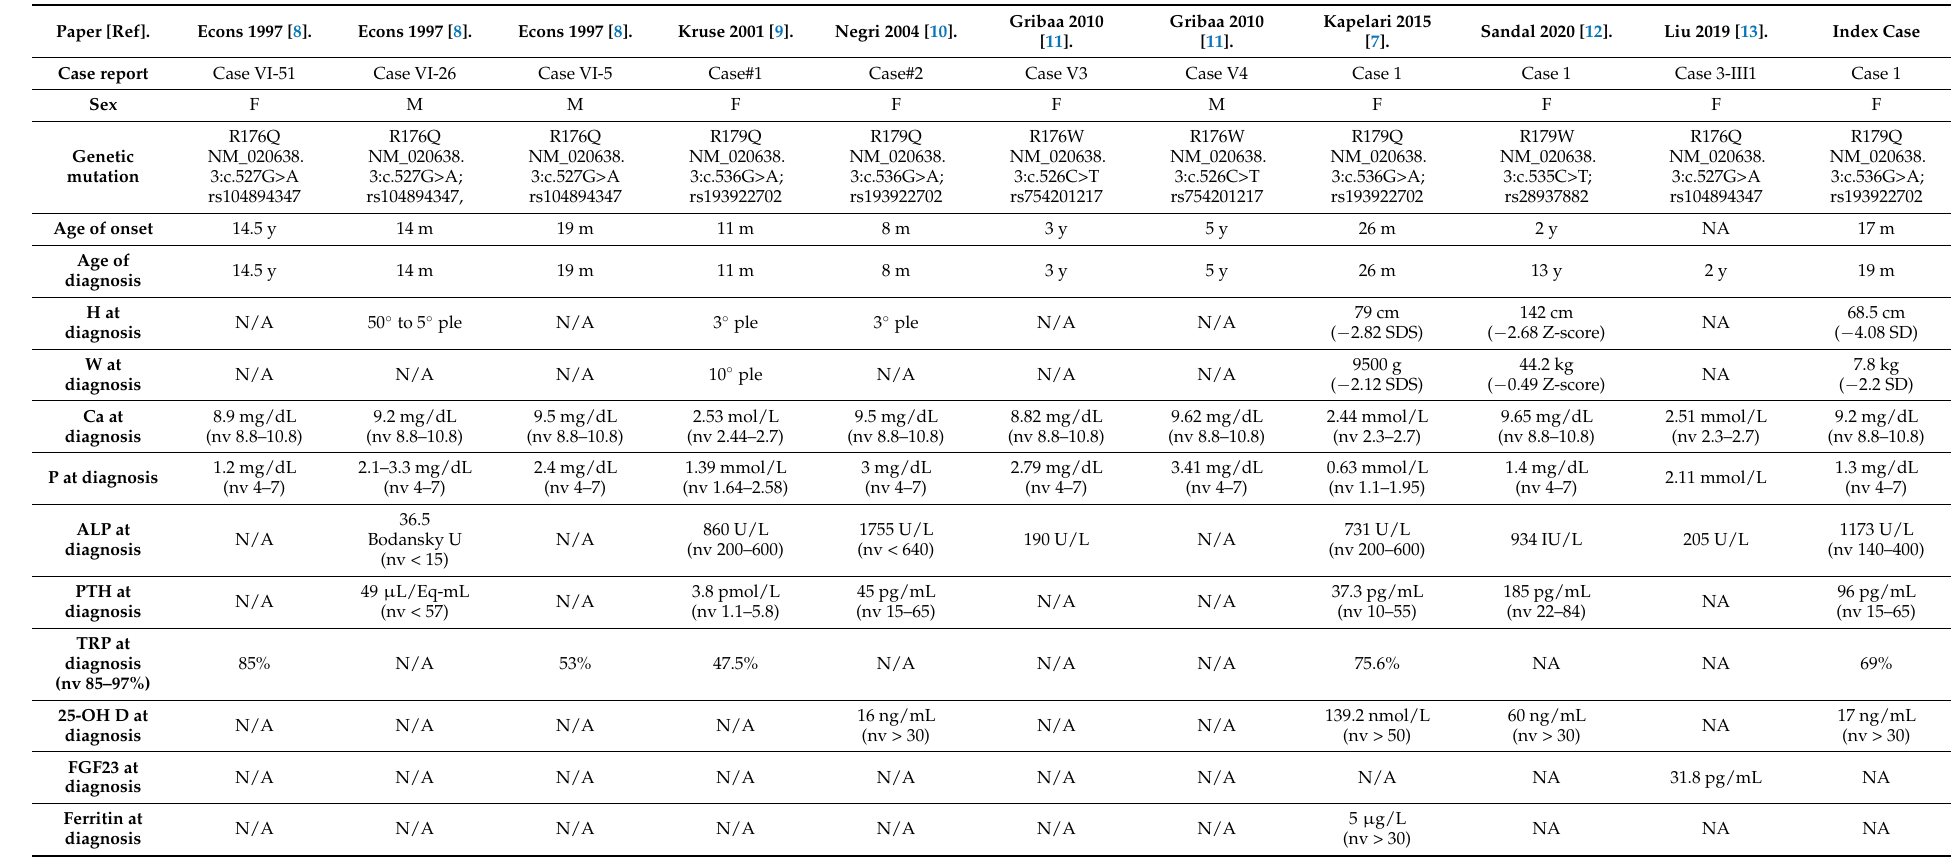
Table 1. Pediatric cases of